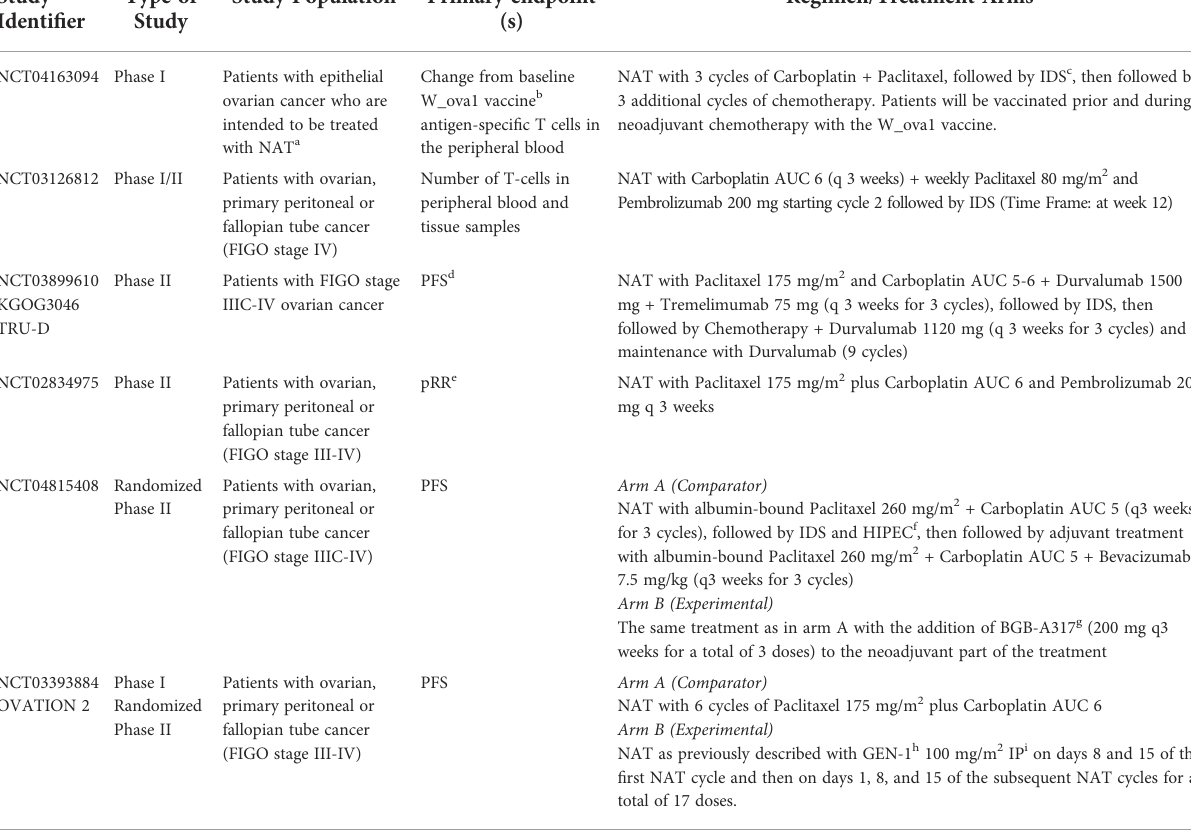
TABLE 5 Selected current clinical trials investigating the role of immunotherapy in the neoadjuvant setting. Study Identi fi